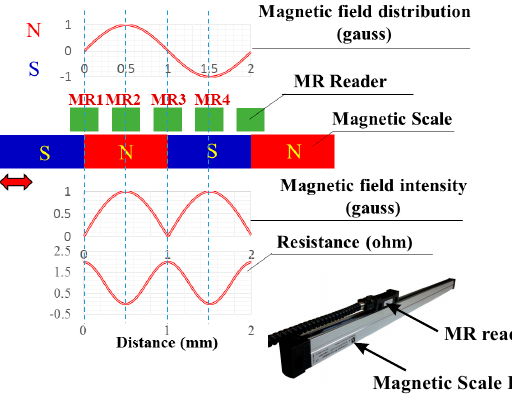
Figure 1. Operation principles of a magnetic linear scale.